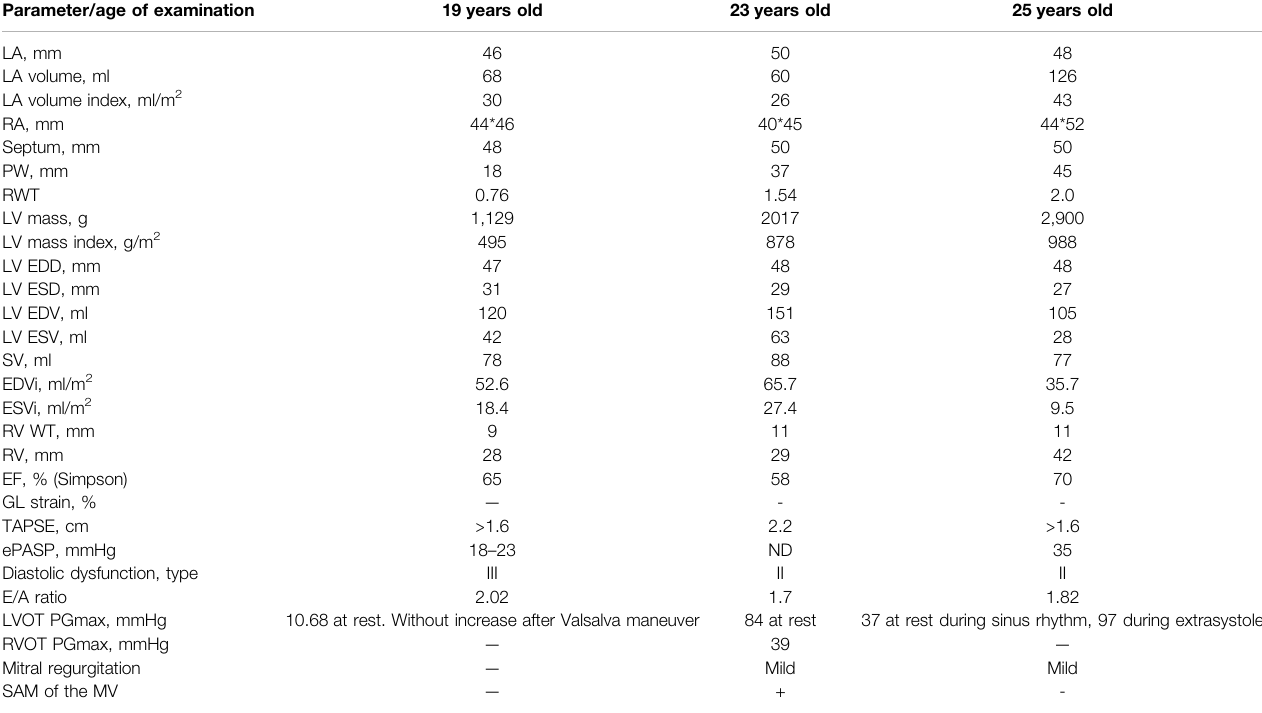
TABLE 1 | Dynamics of echocardiography data in Patient